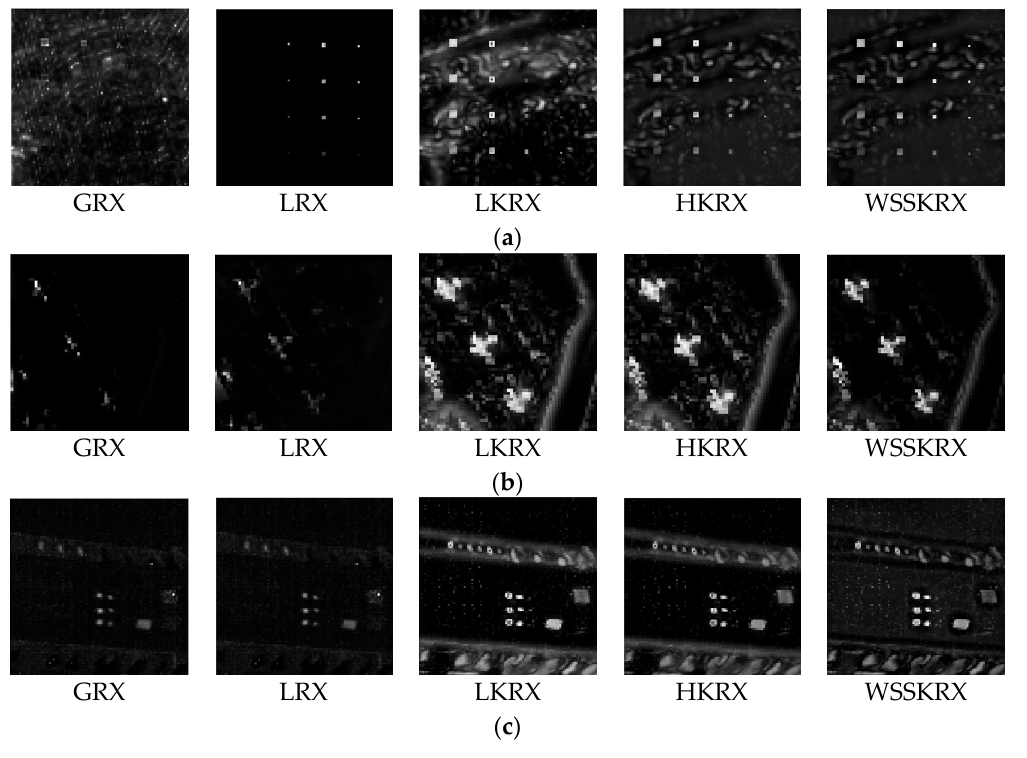
Figure 13. The grayscale detection results of GRX, LRX, LKRX, HKRX and WSSKRX on three datasets synthetic dataset San Diego Airport dataset SpecTIR dataset. ( a ) The grayscale of synthetic dataset; ( b ) The grayscale of San Diego Airport dataset; ( c ) The grayscale of SpecTIR dataset.